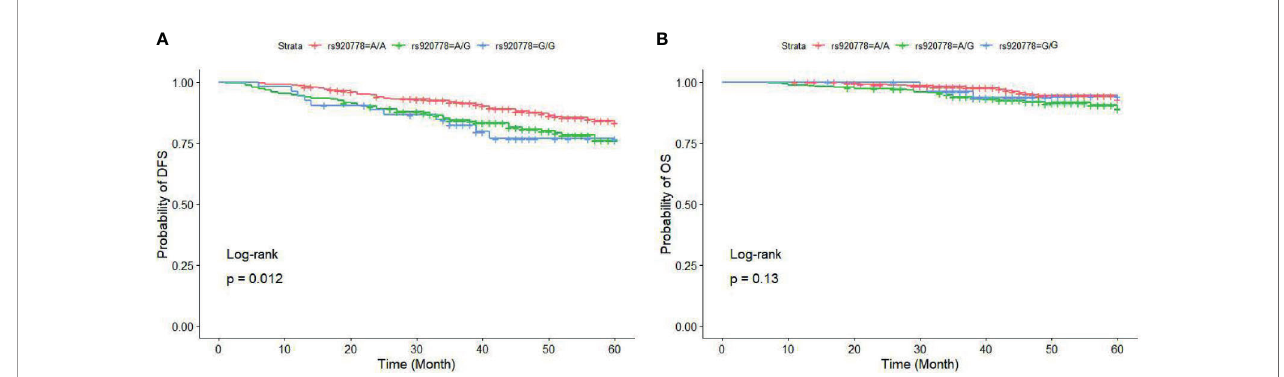
FIGURE 1 | DFS (A) and OS (B) for BC patients with different genotypes of HOTAIR rs920778. BC, breast cancer; HOTAIR , HOX transcript antisense RNA; DFS, disease-free survival; OS, overall survival. The three curves of DFS are statistically signi fi cant (P = 0.012), subjects with GG genotype had a worst DFS (P = 0.048); the three curves of OS are not statistically different (P = 0.13), however, subjects with GA genotype had a worst OS than subjects with AA genotype (P = 0.047).